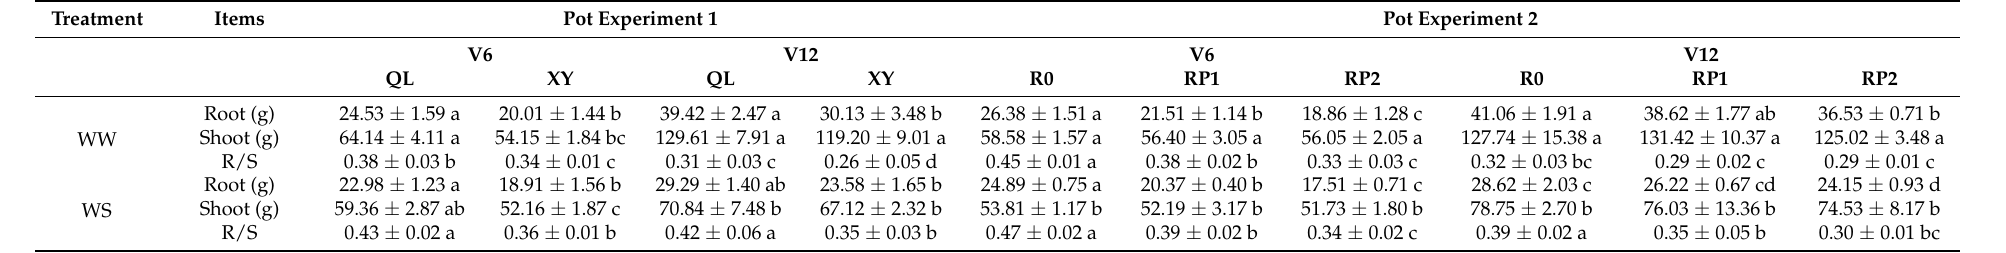
Table 1. Root dry weight, shoot dry weight and root/shoot ratio (R/S), with average values at jointing stage (V6) and anthesis stage